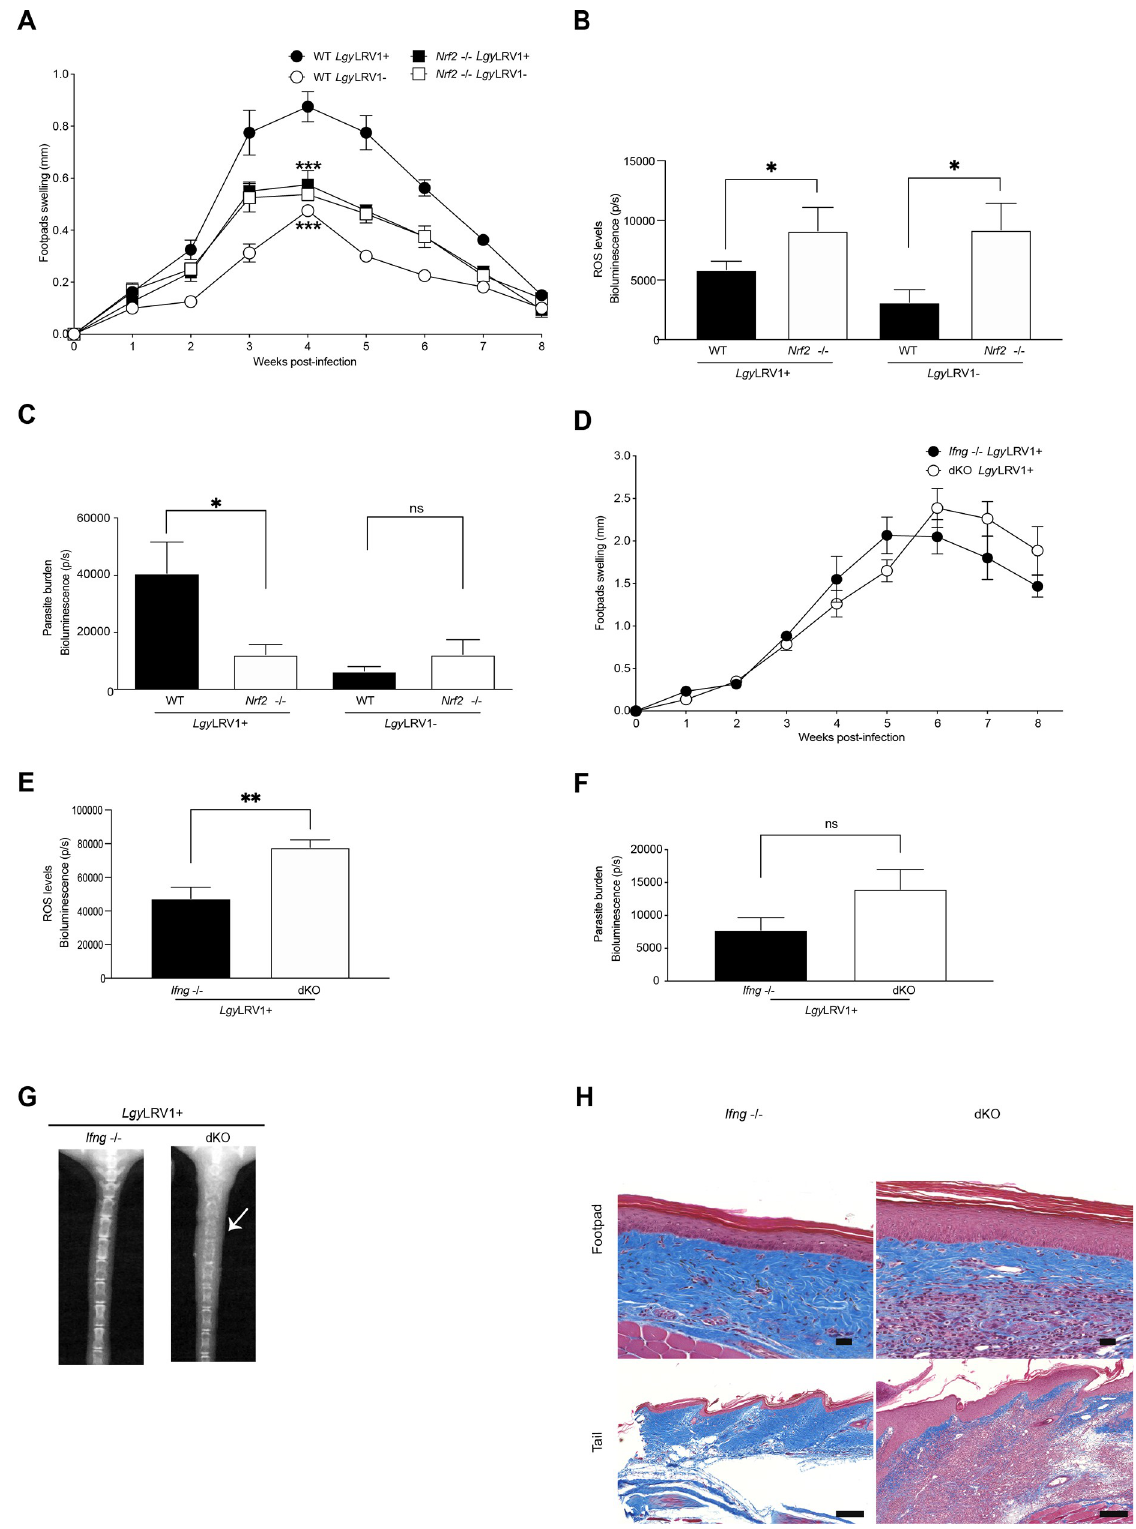
Fig 2. NRF2 participates to lesion development in WT mice and controls disease severity in immunocompromised mice infected with Lgy LRV1+. WT, Nrf2 -/- , Ifng -/- or Ifng x Nrf2 dKO (dKO) mice were infected in both hind footpads with 1x10 6 of either Lgy LRV1+ or